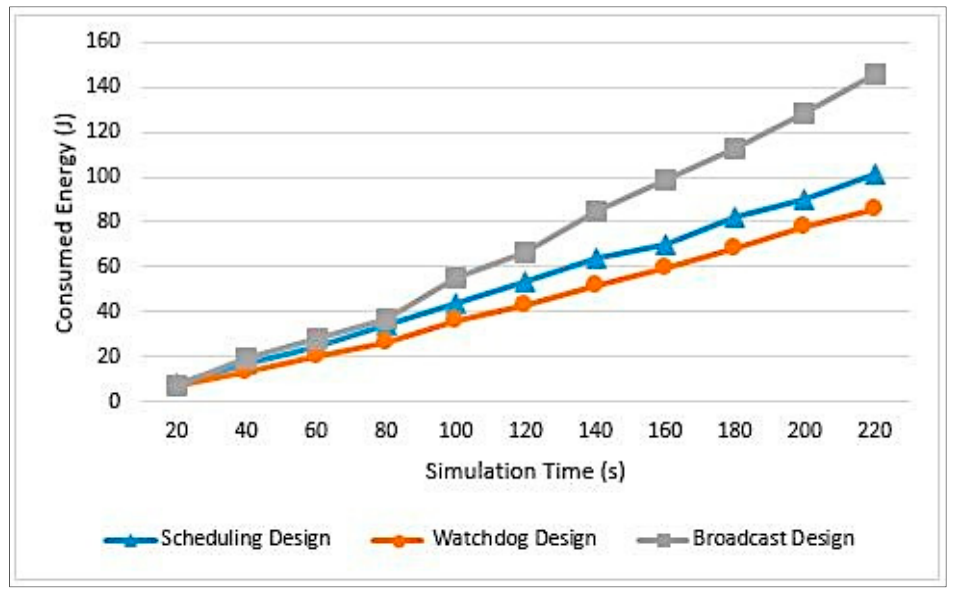
Figure 12. Energy consumption measurements.